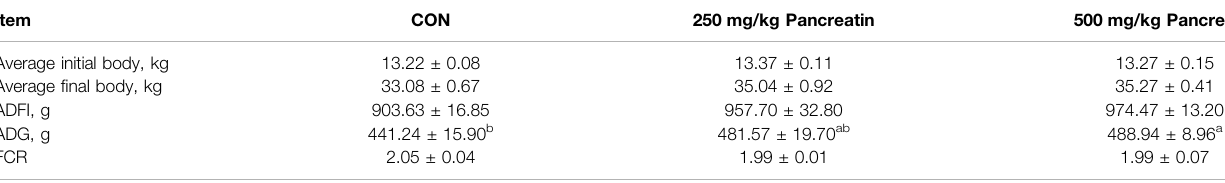
TABLE 3 | Effect of pancreatin on the growth performance of piglets.